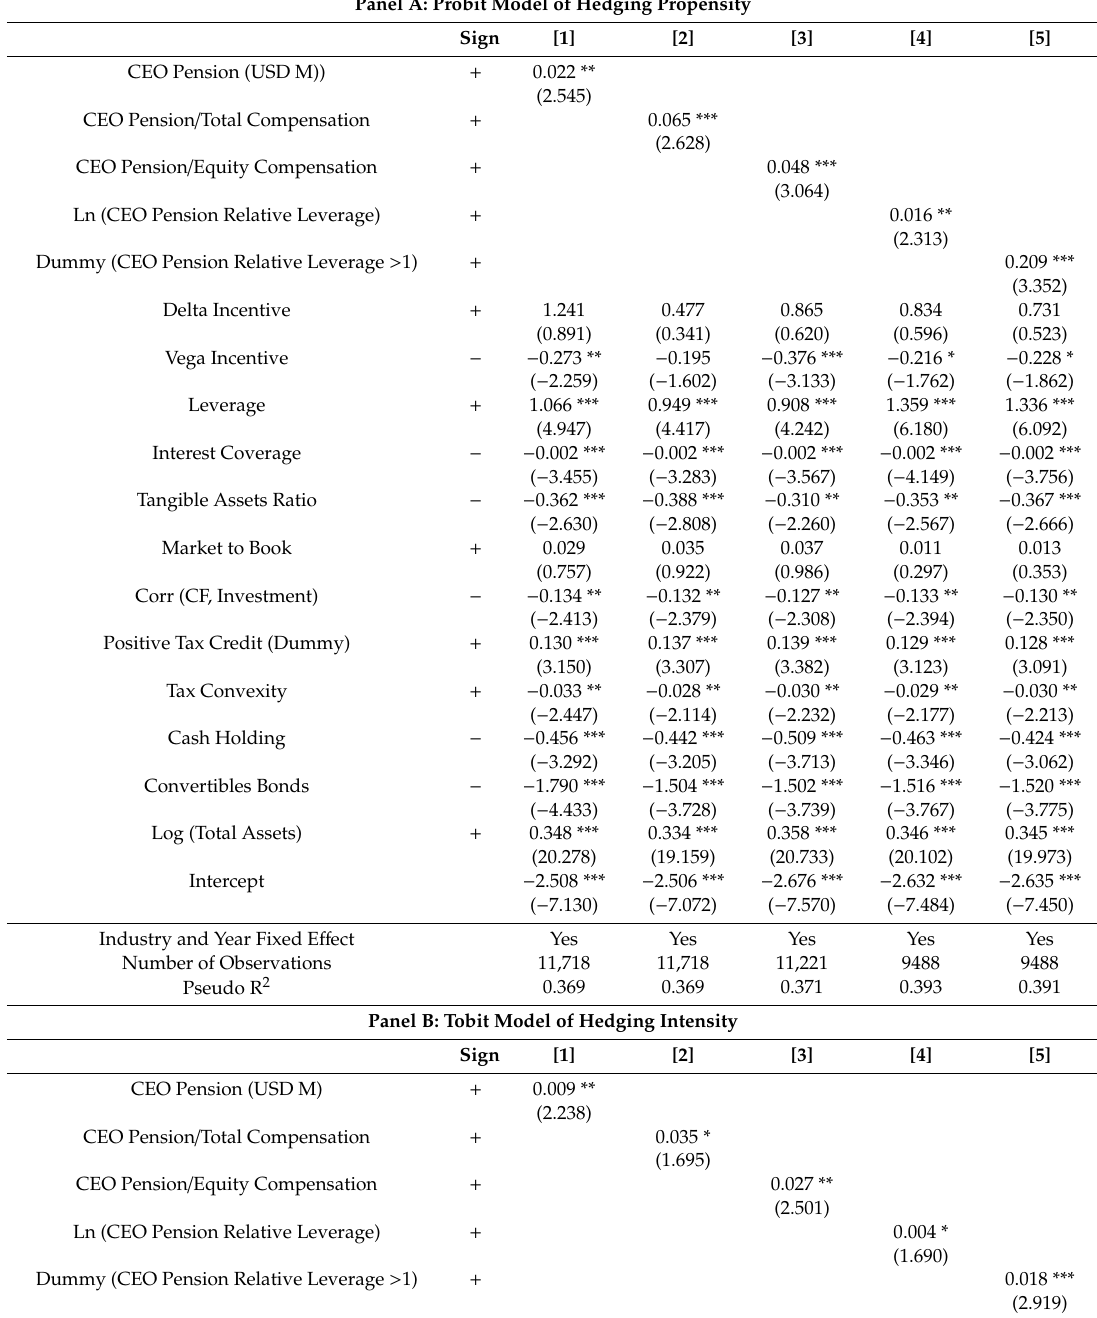
Table 3. Baseline Models of Impact of Pension Incentive on